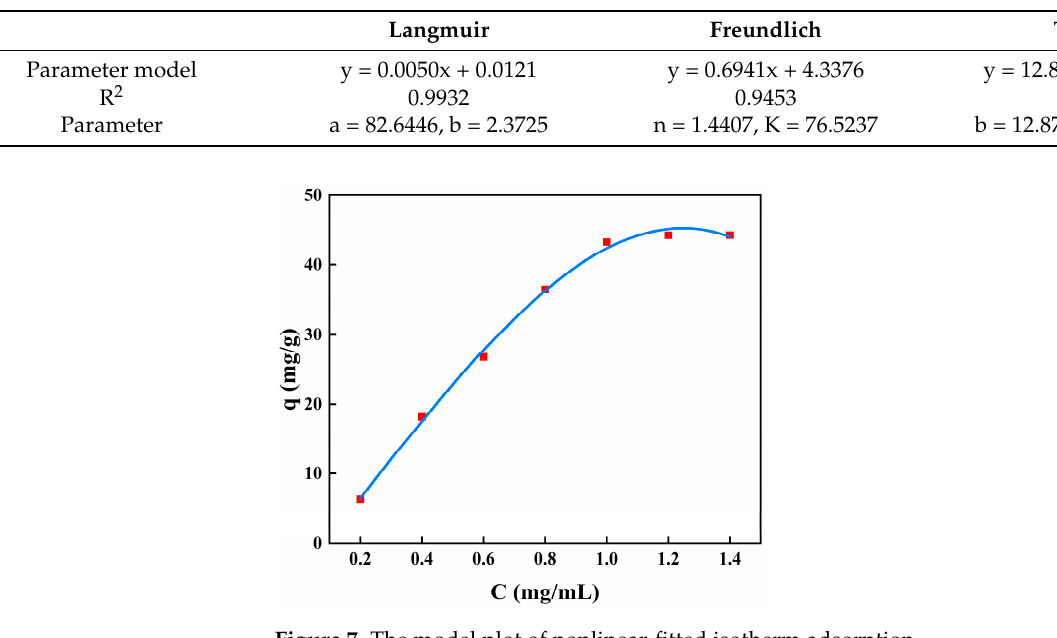
Table 6. Adsorption isotherm parameters.